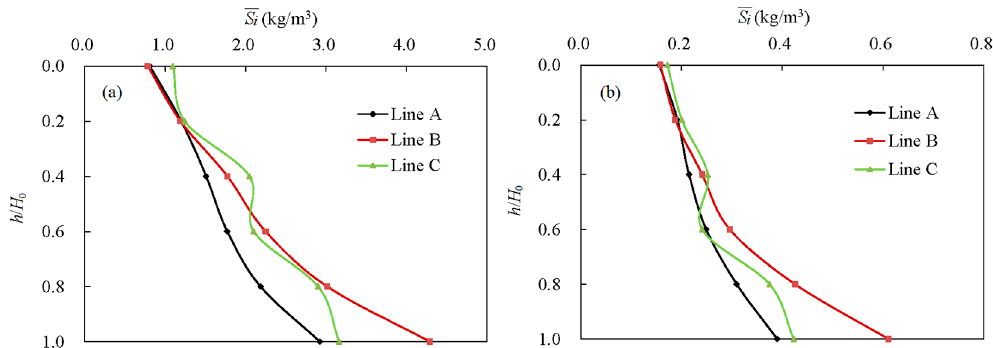
Figure 5. Distributions of S i along lines A, B and C at FS4 during the wet season: ( a ) Spring tide; Figure 5. Distributions of 𝑆 (cid:3114) (cid:3365) along lines A, B and C at FS4 during the wet season: ( a ) Spring tide; ( b ) (cid:3365) along lines A, B and C at FS4 during the wet season: ( a ) Spring tide; ( b ) ( b ) Neap tide. Figure 5. Distributions of 𝑆 (cid:3114) Neap tide. Neap tide.